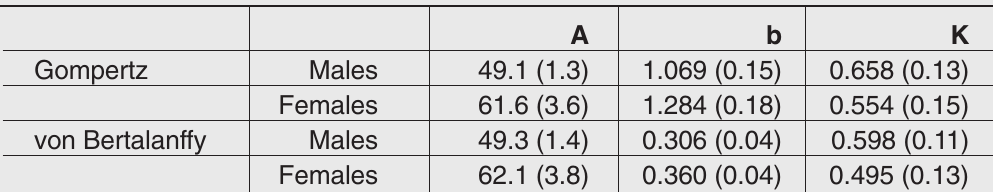
Table 2 : Parameter estimates for the Gompertz and von Bertalanffy growth curves from cross-sectional weight-at-age data for male (n = 59) and female (n = 33) harbour porpoises from Eastern Newfoundland. Standard errors are in parentheses. A = asymptotic length (cm), b = fitted constant (no units), k = growth rate constant (yr- 1 )..